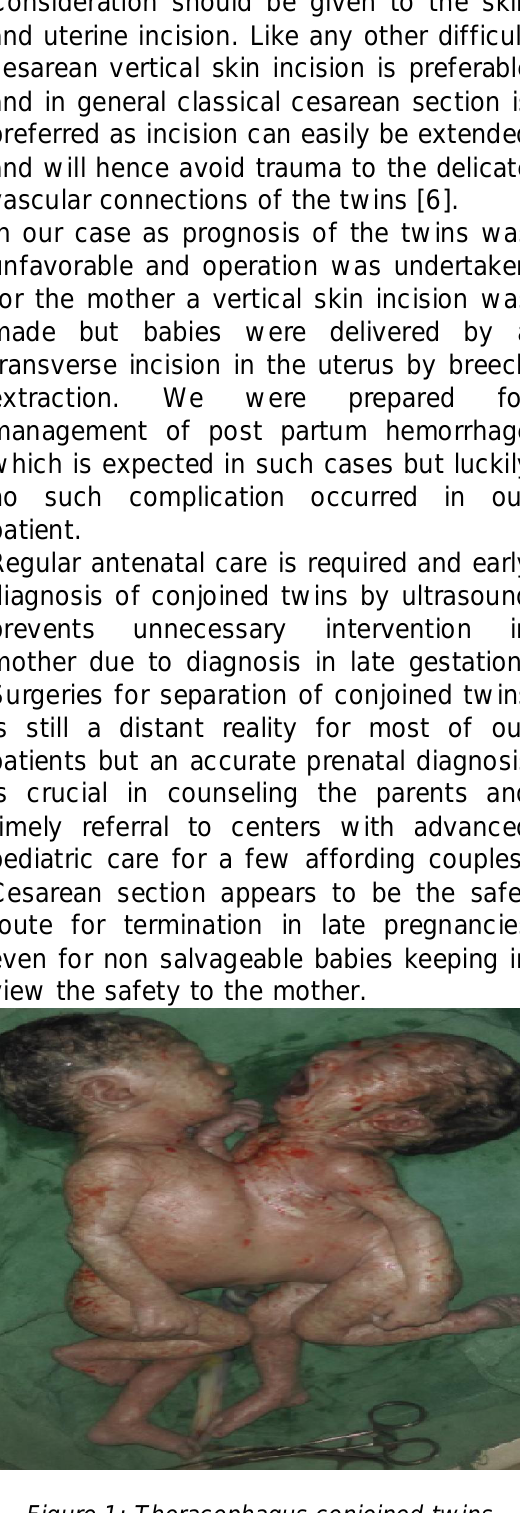
Figure 1: Thoracophagus conjoined twins